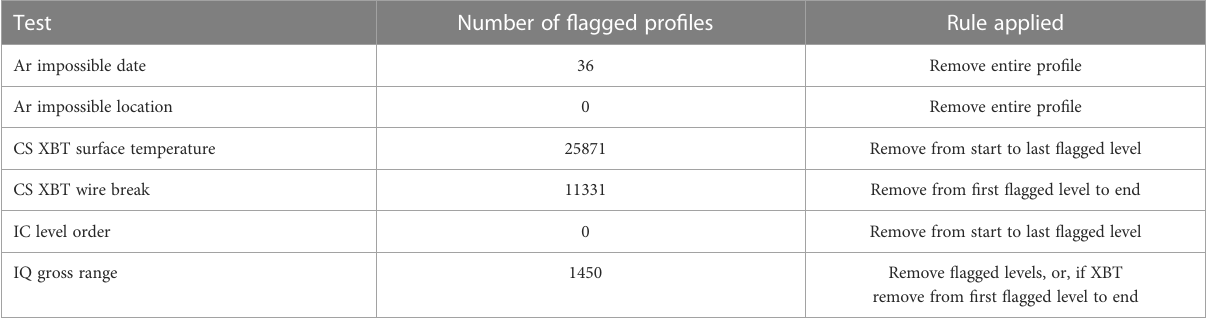
TABLE 2 Pre-selected QC checks, the number of pro fi les that they fl ag out of the 47022 pro fi les from the QuOTA dataset used in this study, and the rule applied to remove the affected data from the QuOTA